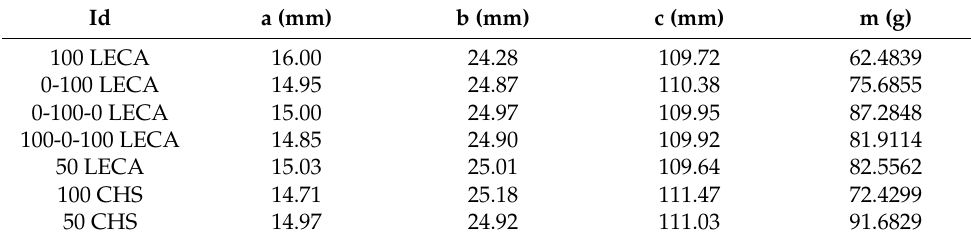
Table 3. Geometric properties of samples used in the experimental modal